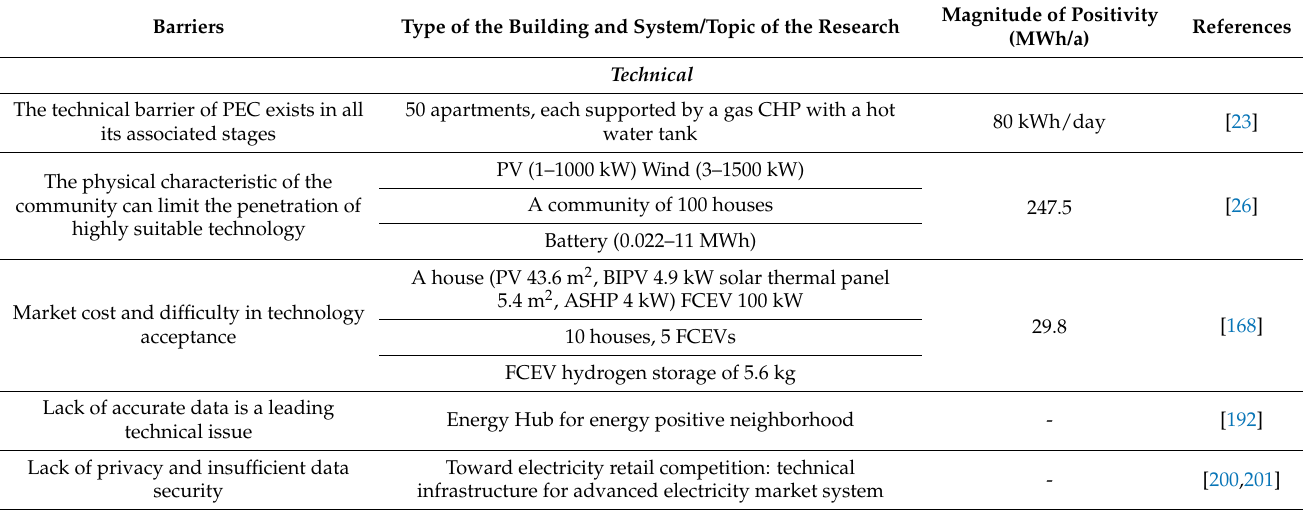
Table 6. Challenges and bottlenecks of the positive energy